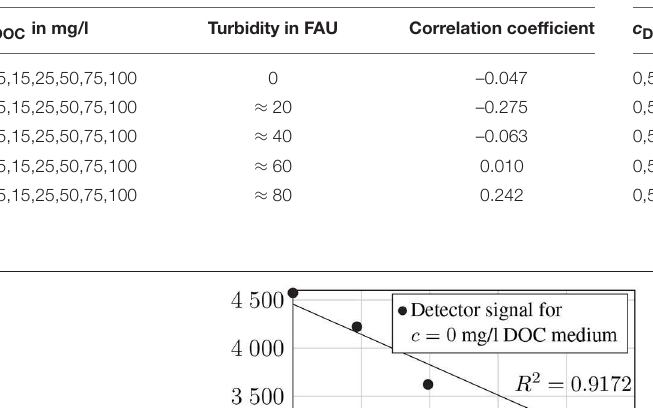
Frontiers in Earth Science |